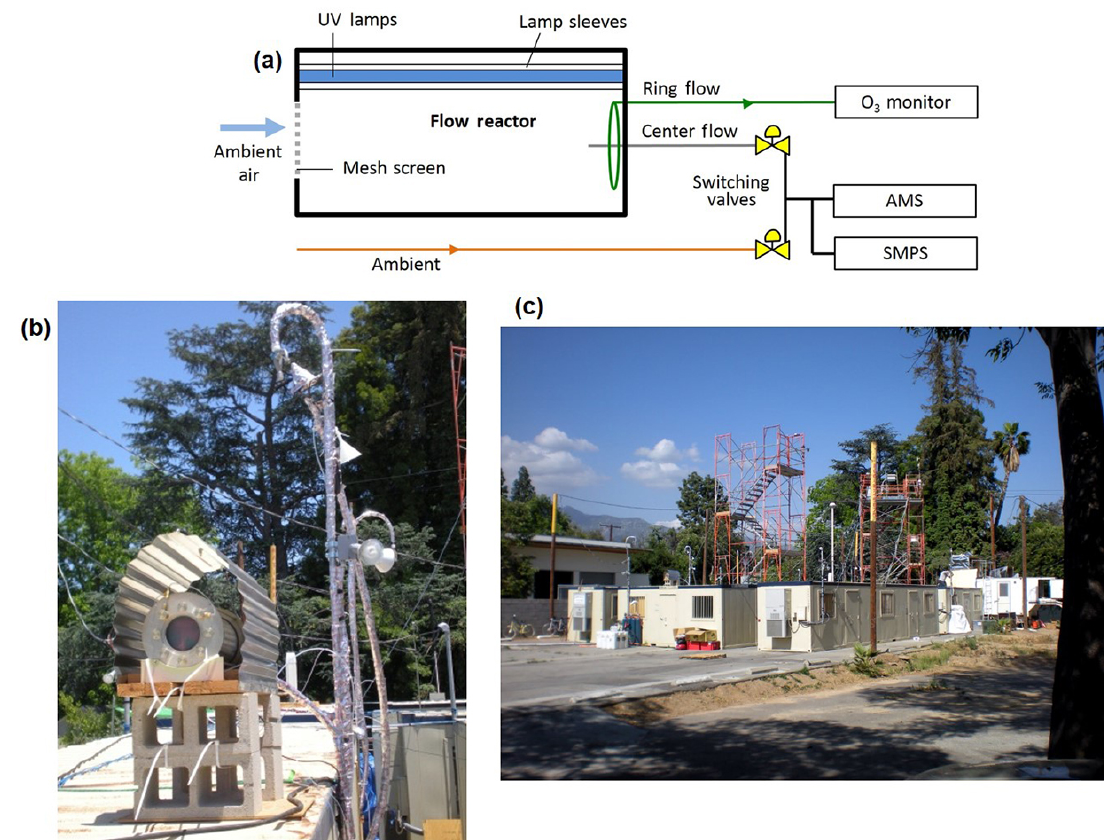
Figure 1. (a) Schematic of the oxidation flow reactor (OFR) coupled to an Aerodyne high-resolution time-of-flight aerosol mass spectrometer (AMS), scanning-mobility particle sizer (SMPS), and ozone (O 3 ) monitor. An ambient sampling line allowed for direct sampling of ambient air. Computer-controlled switching valves allowed for sampling in alternation from the reactor and ambient lines. Voltage supplied to UV lamps were varied via programmable computer control to step through oxidant concentrations in the reactor. Ring flow was via a PTFE Teflon line and was used for gas-phase measurements. Center flow was a copper line that continuously pulled the sample for aerosol analysis. (b) Photograph of the reactor with a sun/rain cover and of the ambient aerosol inlet (right, covered by foil insulation) on the trailer roof during CalNex. (c) Photograph of the sampling site showing the different trailers and inlets. The OFR can be seen on top of the leftmost trailer, next to the AMS and SMPS ambient